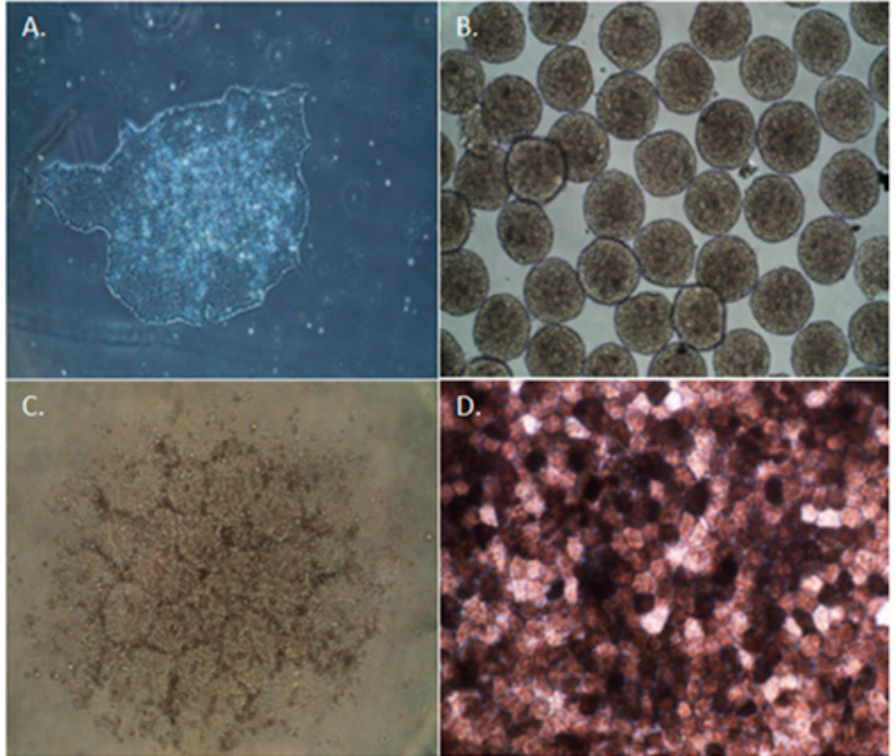
Figure 1. Differentiation of induced pluripotent stem cells (iPSCs) toward a retinal pigment epithelium (RPE) fate. Undifferentiated iPSC colony at day 0 ( A ); embryonic bodies form by day 7 ( B ); and eventual formation of neural aggregates ( C ) by day 14; A pigmented monolayer of iPSC-derived RPE cells forms by day 45 of the differentiation process ( D ). With the full permission of all authors of the original publication, Figure 3 of [76] has been included here.